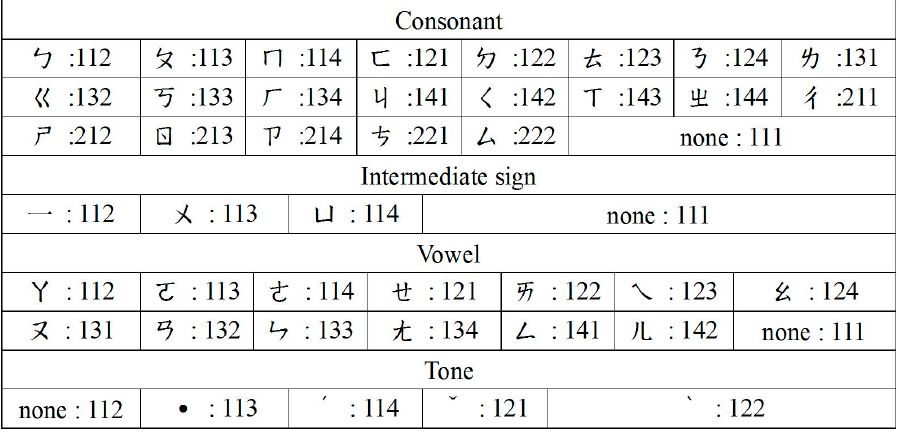
Figure 7. Three ‐ numeric ‐ code table of the Chinese phonetic alphabet.